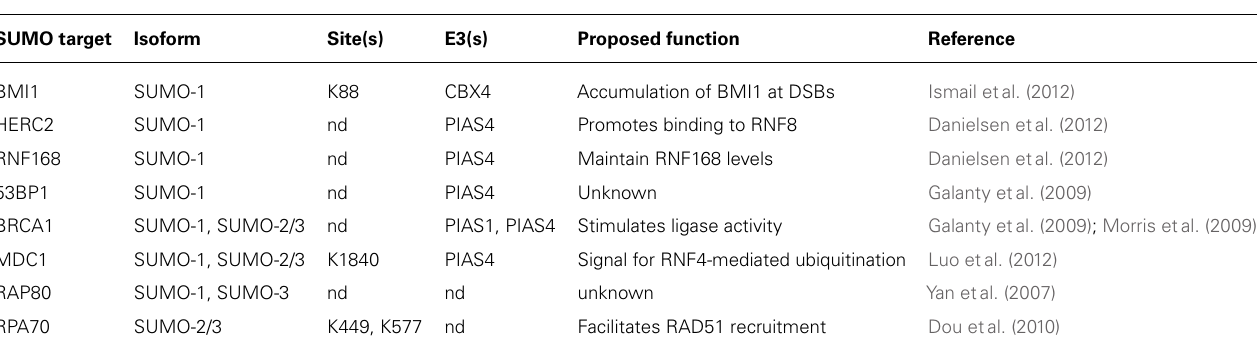
Table 2 | Ubiquitination targets in the early